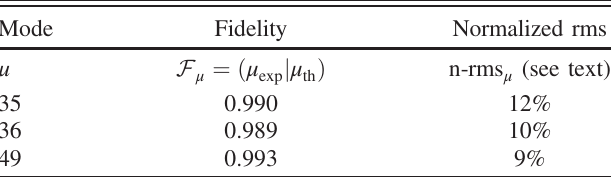
TABLE I. Quantitative comparison between theoretical pre- dictions and experimental results for normal-mode weights as obtained from scanning probe microscopy of the 49-site kagome